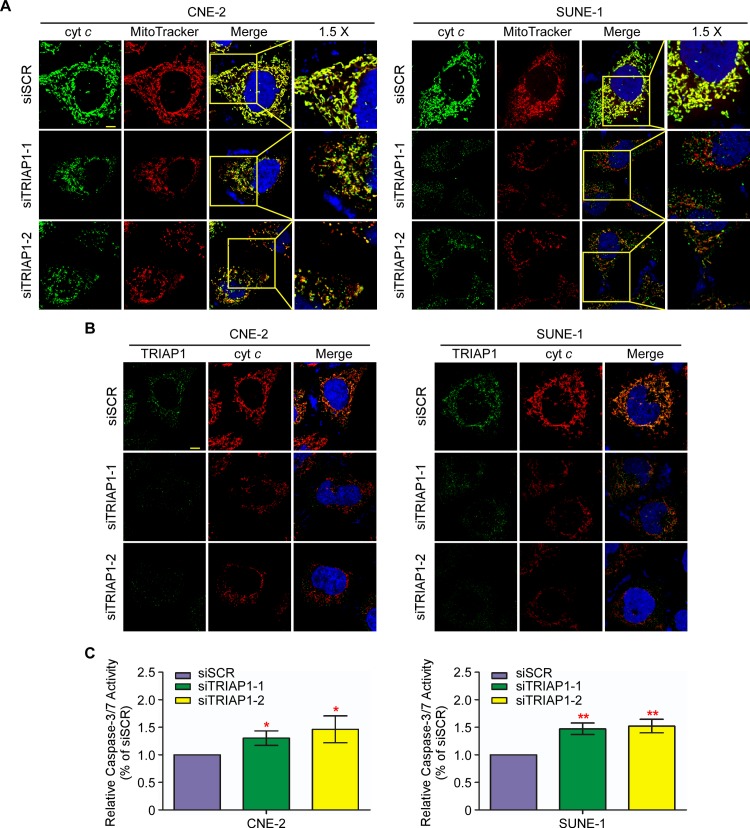
TRIAP1 regulates apoptosis through controlling the release of cytochrome c.A and B, Release of cytochrome c is increased upon TRIAP1 knockdown. Representative images of mitochondria, cytochrome c (A) and TRIAP1 (B) subcellular locations for CNE-2 (left panel) and SUNE-1 (right panel) cells transiently transfected with siSCR, siTRIAP1-1 or siTRIAP1-2 after staining with MitoTracker Red, cytochrome c or TRIAP1 primary antibodies. Scale bar, 10 μm. (C) Caspase-3/7 assay for cells with TRIAP1 knockdown. Each experiment was independently repeated at least three times. The data are presented as the mean ± s.d. Student’s t-test, * P < 0.05, ** P < 0.01.